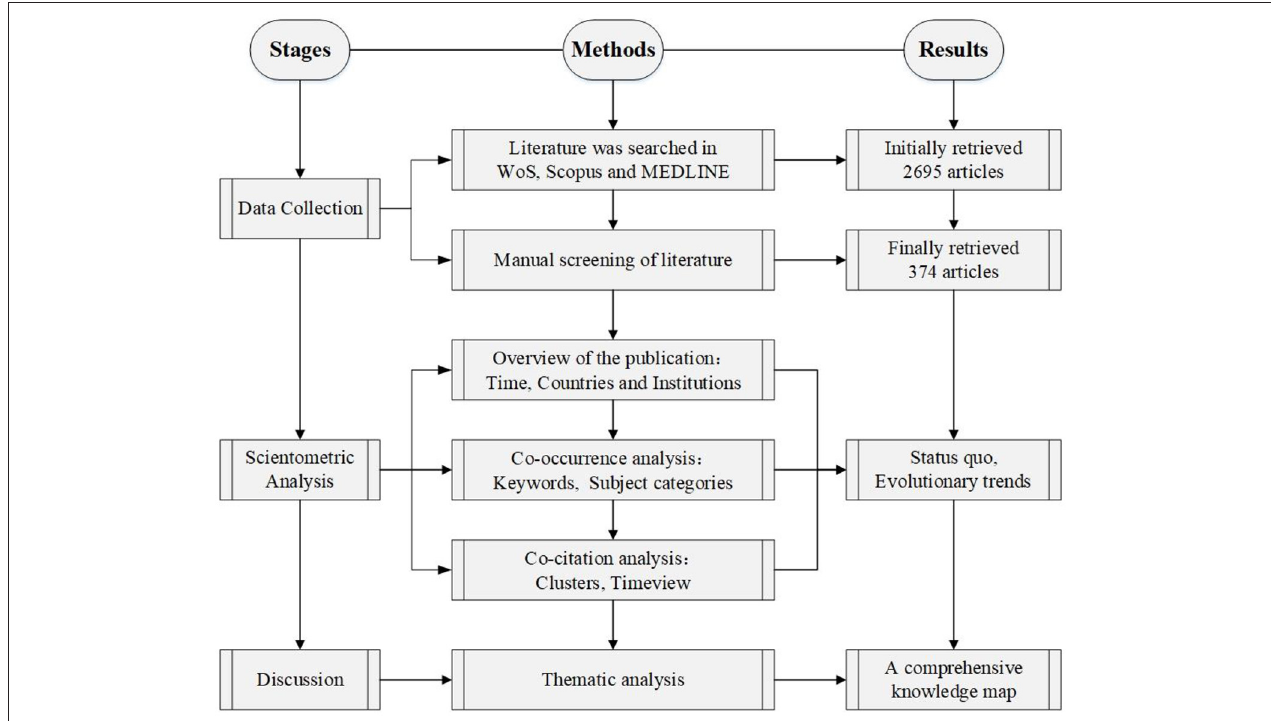
FIGURE 1 | Research